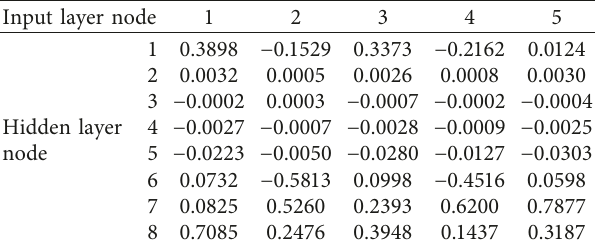
Table 3: Connection weight table of input layer nodes and hidden layer nodes.